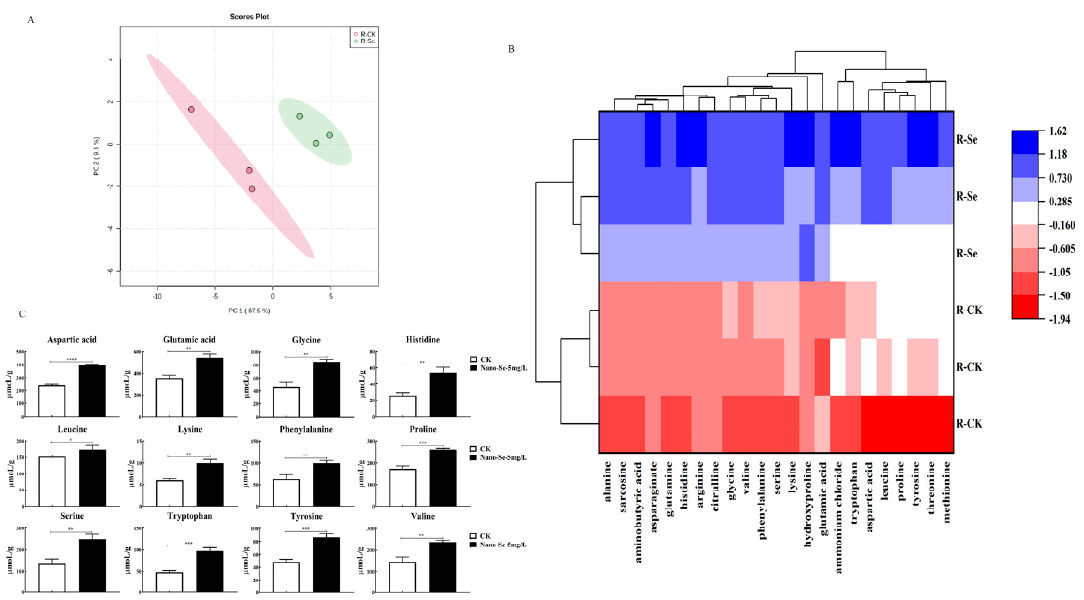
Figure 4. The PCA ( A ) and heatmap ( B ) displaying changes in amino acids. Nano-Se (5 mg/L) treatment notably enhanced levels of 12 amino acids ( C ). Data are presented as mean ± SEM (* p < 0.05, ** p < 0.01, *** p < 0.001, **** p < 0.0001. n = 3).